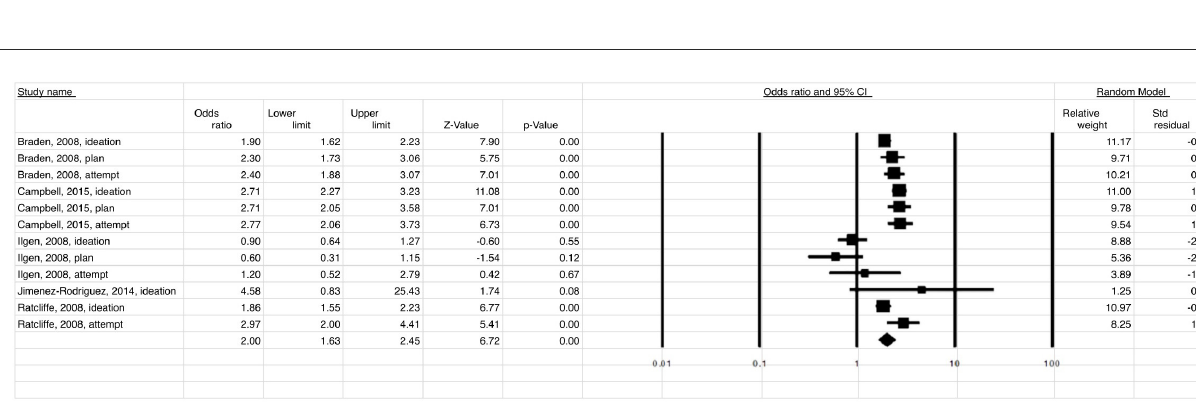
FIGURE3 Relationship between suicide ideation and attempt (OR = 2.00) in patients with back/neck pain when compared to healthy controls.